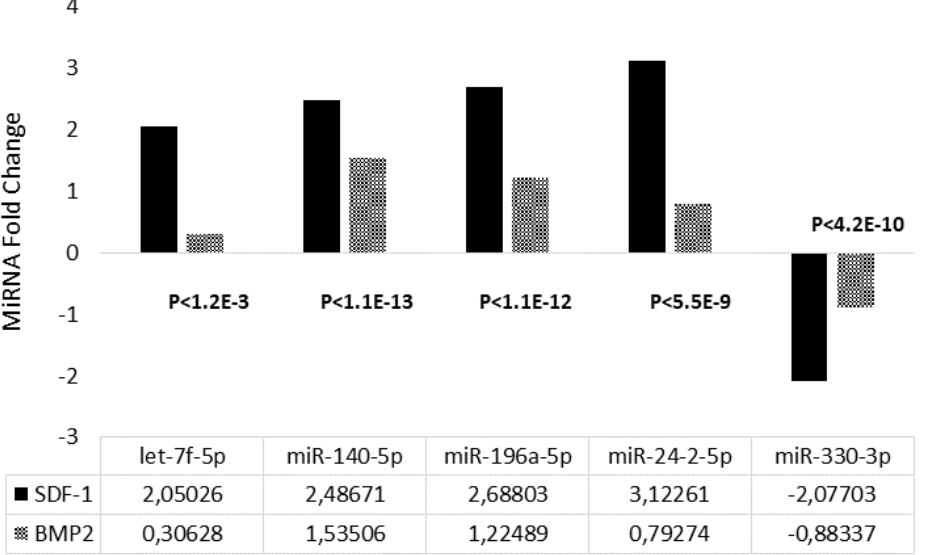
Figure 4: Common miRNAs regulated in the presence of SDF-1 treatment (at 72 hours) and BMP2 treatment (at 72 hours). BMP2 data was determined from GEO database analysis of dataset by Bae et al . (GEO accession GSE37036) in which C2C12 cells were treated with BMP2 (300 ng/mL) or vehicle (control) for 72 hours (n = 2). Afterwards miRNA was isolated and Exiqon miRNA microarray was performed yielding a total of 34 differentially expressed miRNAs, of which five common miRNAs showed similar trend in the presence of SDF-1 and BMP2 treatment. Reported p -values are adjusted values calculated by GEO2R analyzer that indicate significance in the fold change (differential expression) for BMP2 treatment versus